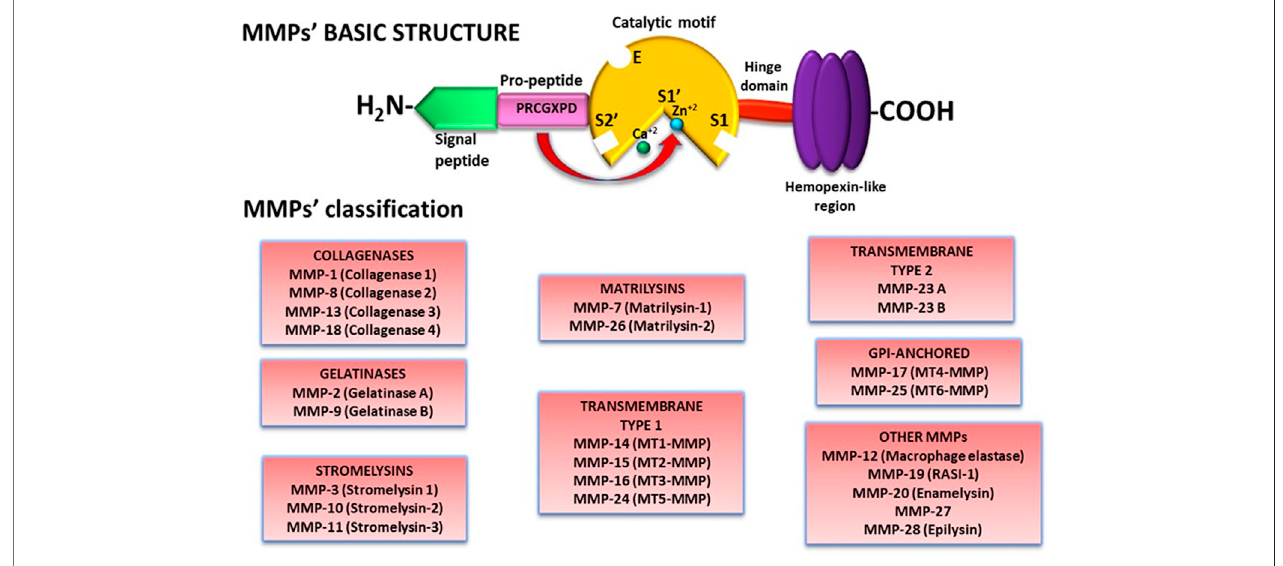
FIGURE 1 | MMPs structure and classi fi cation. Besides a basic structure, MMPs have molecular characteristics that differentiate one from another. Therefore, MMPs have been classi fi ed according to their substrate speci fi city and molecular structure in 8 groups. Abbreviations: MMP, matrix